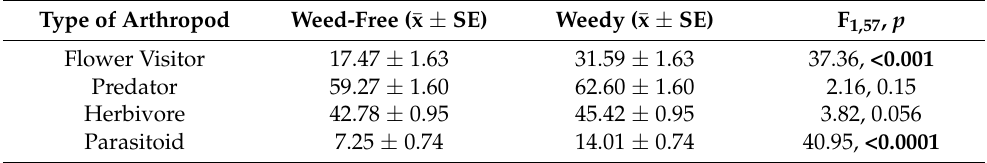
Table 1. Numbers of arthropods in different categories on mango, weedy vs. weed-free. Significant differences have p -values in bold, as shown by GLM multivariate analysis of variance (MANOVA). N = 30 trees for each treatment.